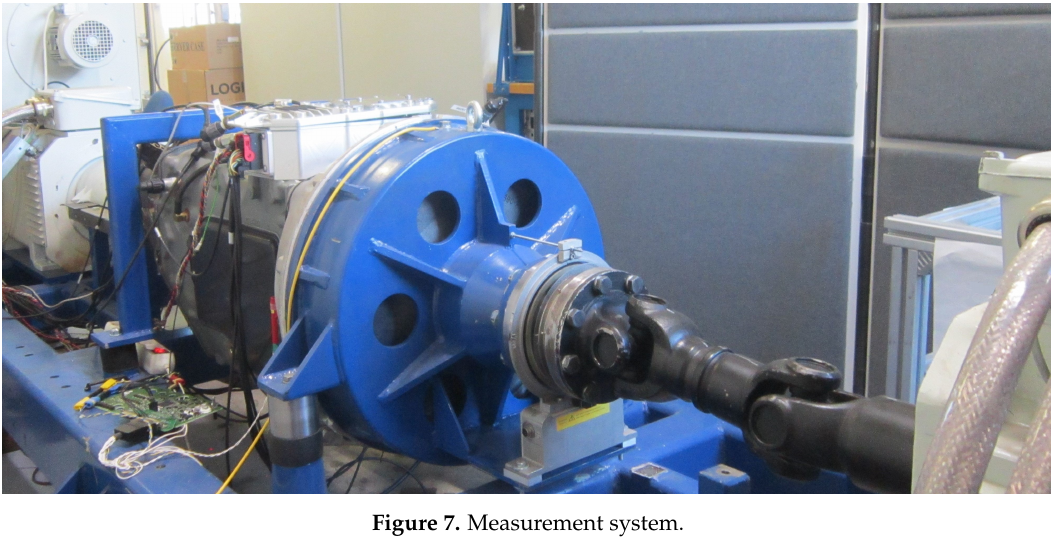
Figure 7. Measurement system.